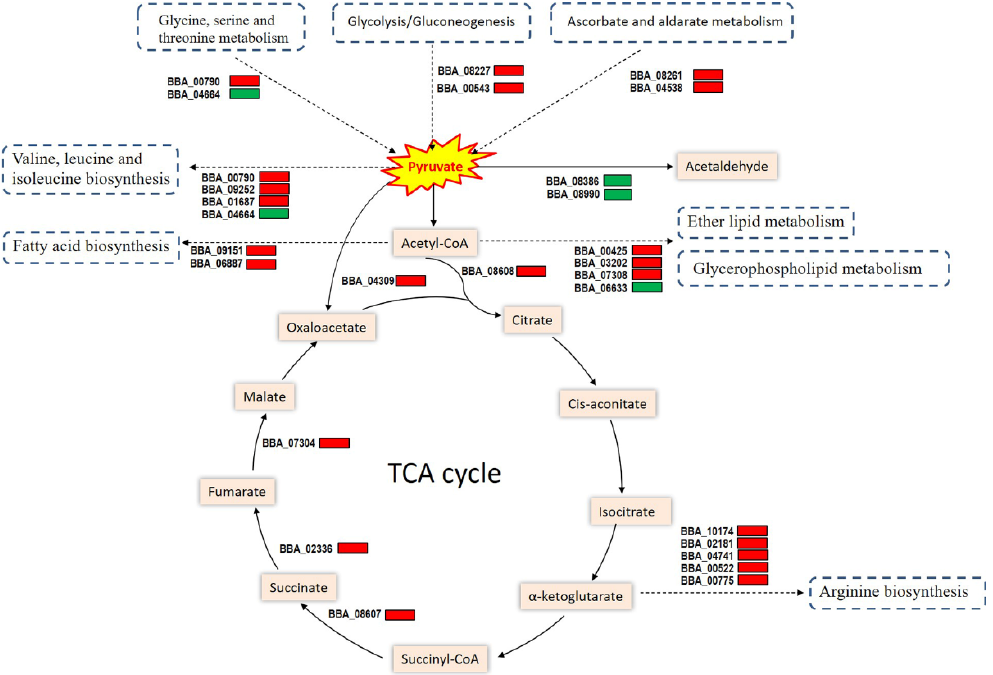
Figure 5. Diagram for involvements of identified DEGs in the pyruvate metabolism and related pathways of the Δ cdc42 mutant versus the WT strain. Red and green denotes up- and downregulated genes, respectively. Each gene with its tag locus in the B. bassiana genome is illustrated with its expression status in Δ cdc42 (red or green) as compared to WT.